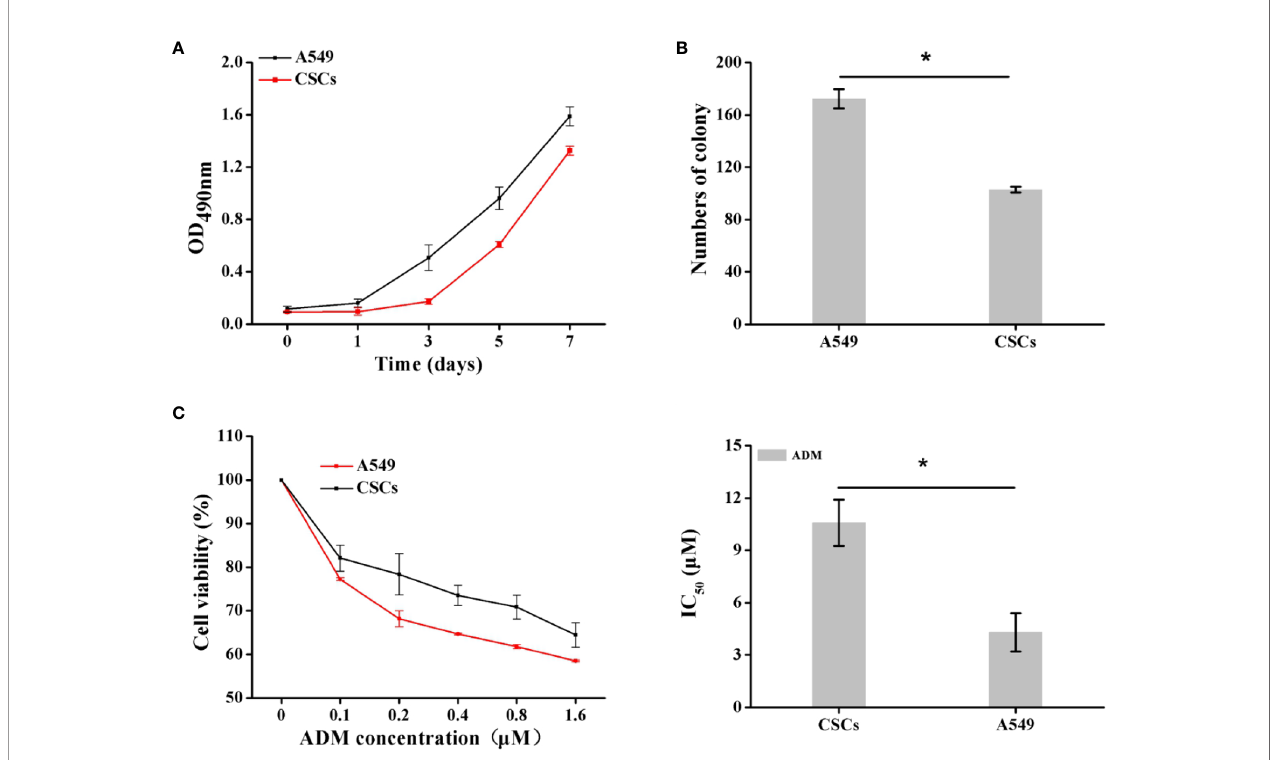
FIGURE 8 | Identi fi cation of proliferation capacity and drug resistance of CSCs. (A) The growth curve of A549 CSCs based on OD 490nm value on days 1, 3, 5, and 7. (B) The comparison of colony formation ability between A549 and CSCs for 14 days. (C) Viabilities of A549 cells and CSCs after treating with ADM (0, 0.1, 0.2, 0.4, 0.8, and 1.6 m M) for 24 h were determined by MTT assay. Data were expressed as mean ± SD ( n = 3). * P < 0.05.